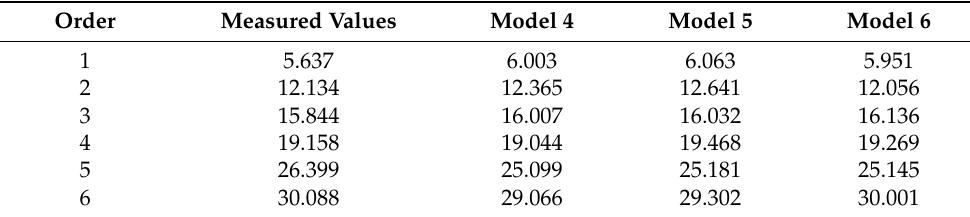
Figure 8. Simplified calculation model. Table 6. Calculation results of simplified model for sample